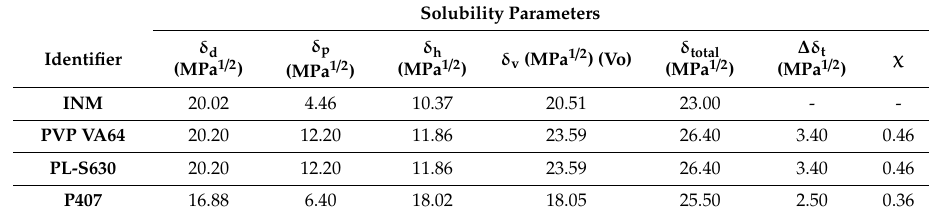
Table 6. Calculated HSPs of and drug–polymer interaction factor for drug and polymers.